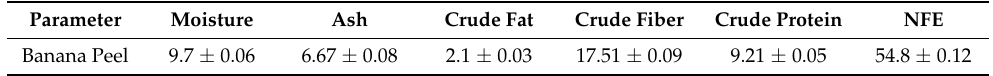
Table 1. Proximate Composition (%) of Banana Peels.